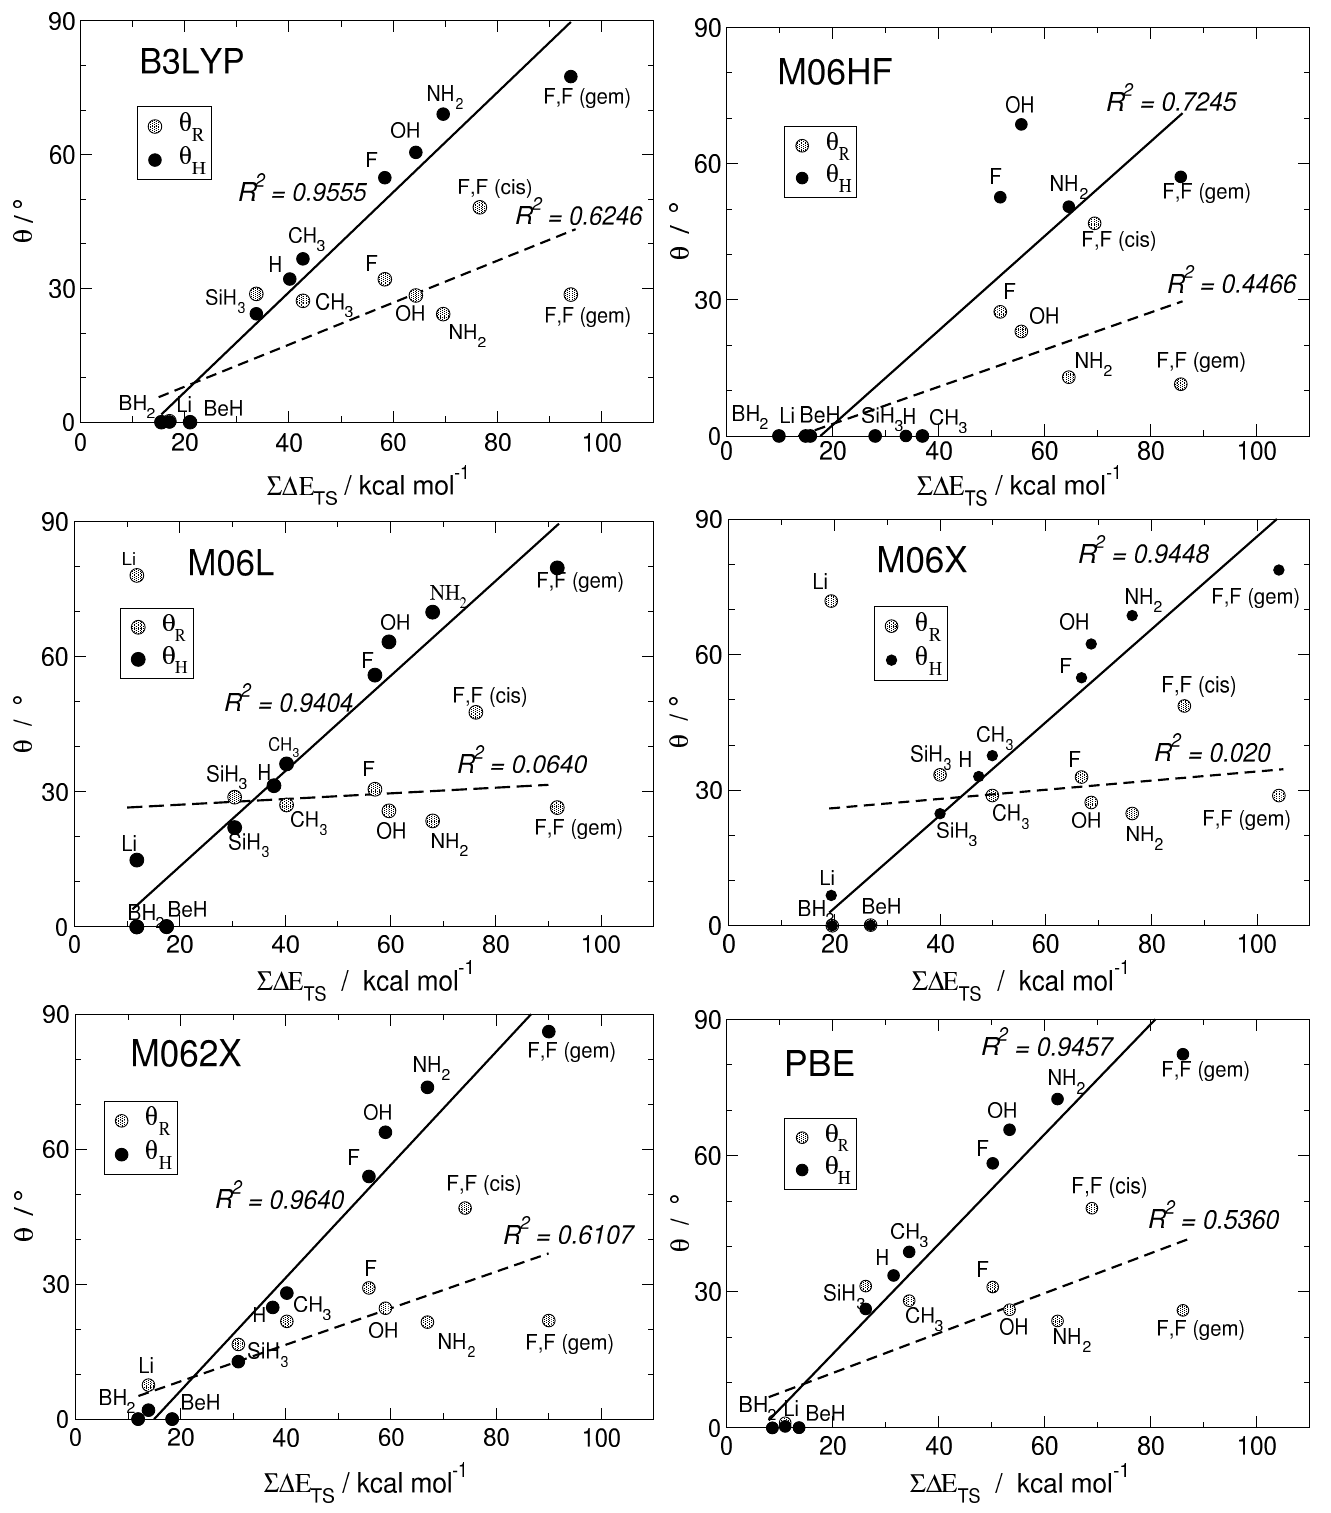
Figure 3. Angles of pyramidalization vs. ∑ ∆ E TS of different mono- and di-substituted disilenes computed with B3LYP, M06HF, M06L, M06X, M062X, PBE functionals, along with their linear regressions and the corresponding (squared) correlation